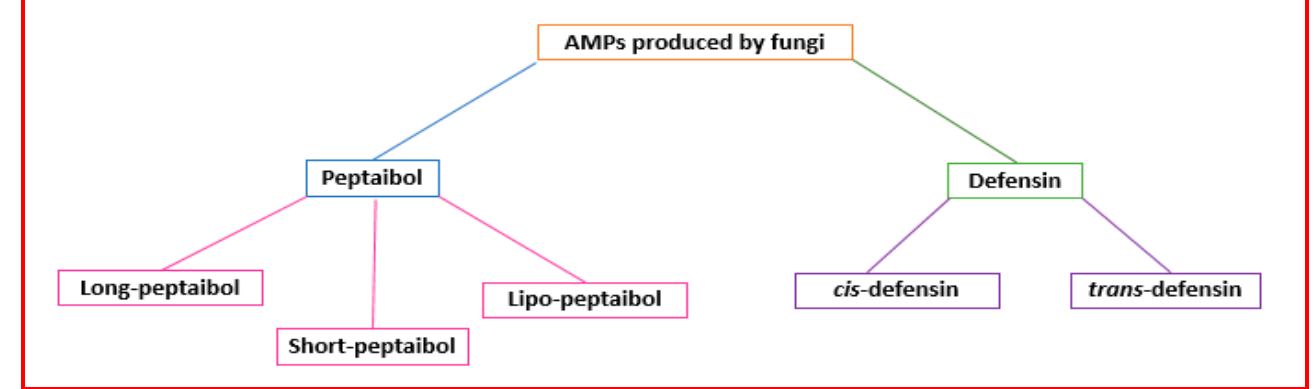
Figure 5. Classification of the AMPs produced by plants.